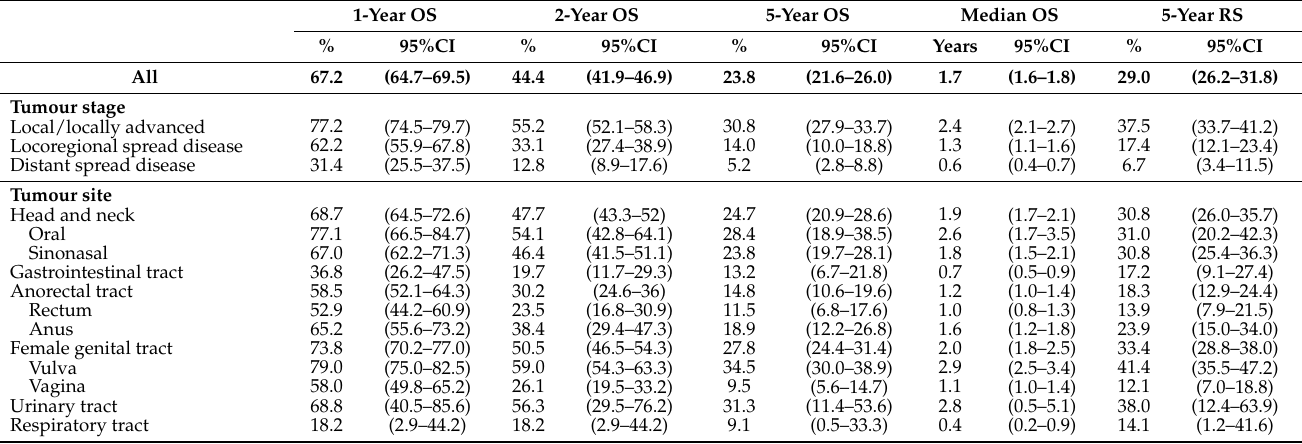
Table 3. Overall 1-, 2-, and 5-year and median survival and 5-year relative survival for patients with mucosal melanoma by stage and tumour